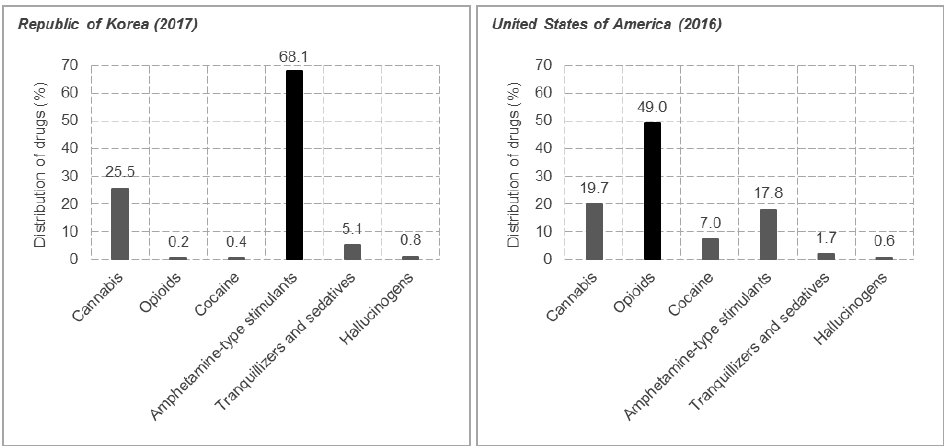
Figure 1. Chemical structure of methamphetamine.